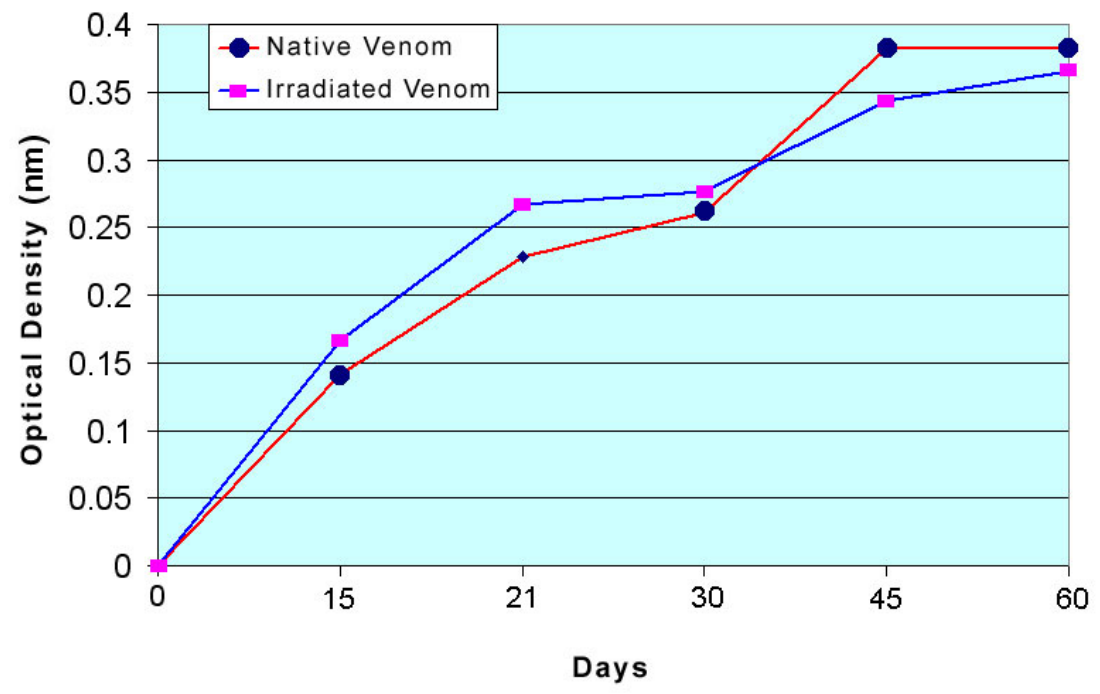
Figure 1: Distribution of the optical densities mean values in different moments, using serum from animals inoculated with Bothrops jararaca venom, native (GI) and 60 Co- irradiated (GII), diluted in 1:200. G I = G II; F = 1.28 < F = 7.71 ( α = 5 %). Lines critical x D x D x D x D x D ; F = 155.03 > F = 6.39 ( α = 5 D 0 15 21 30 45 60 Columns critical